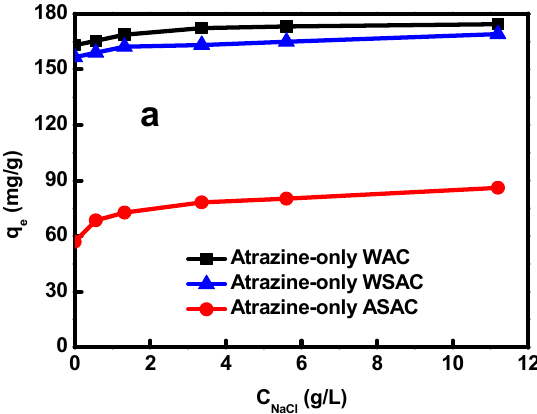
Figure 6. Effect of NaCl concentrations on the adsorption of atrazine on ACs.